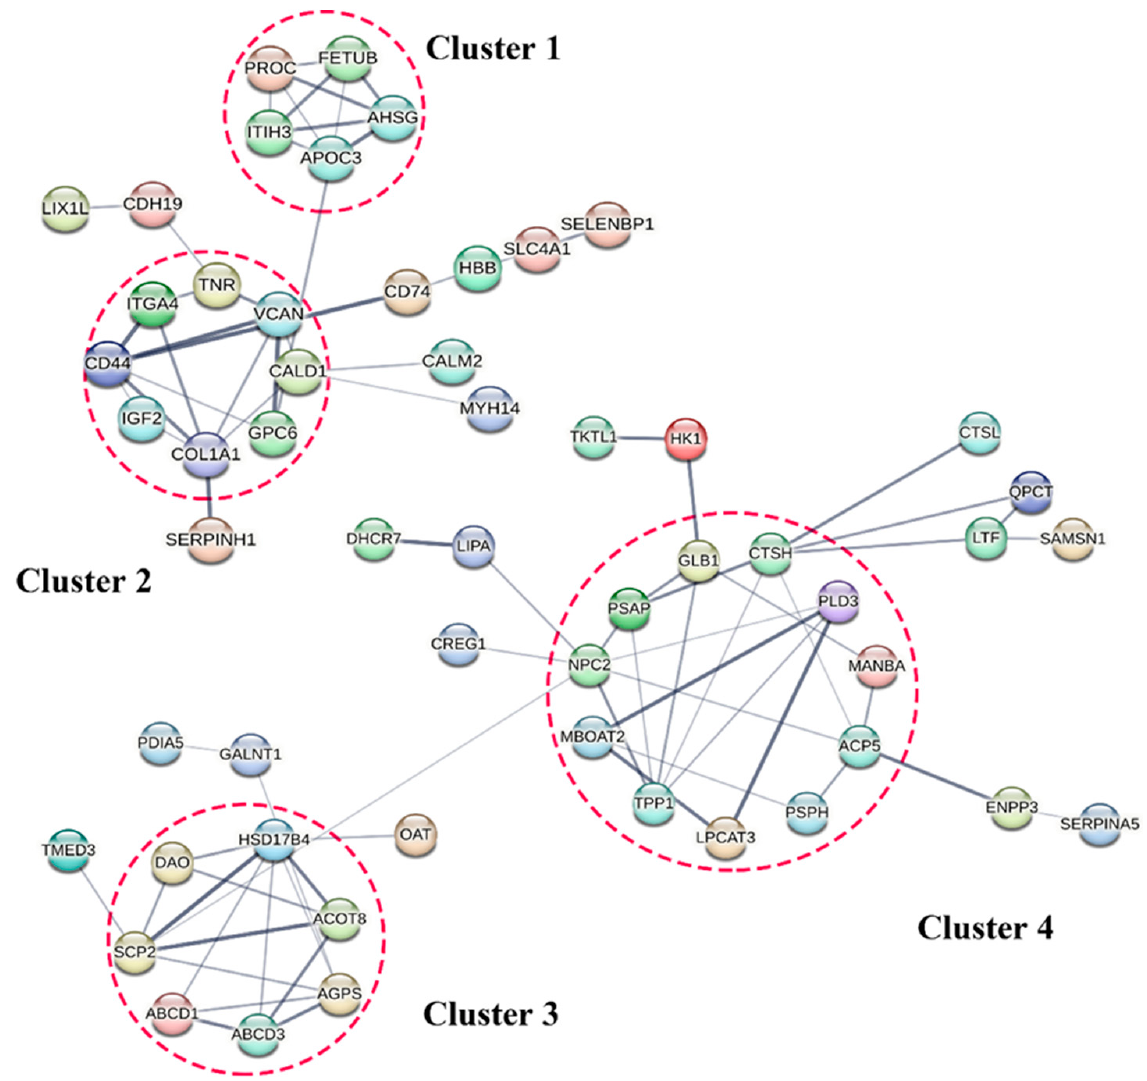
Figure 6. Network diagram of differential protein interaction in epididymal cauda. The protein– protein interaction network diagram was drawn using STRING. Cluster 1 and Cluster 2 represented upregulated DEP aggregation. Cluster 3 and Cluster 4 were formed when DEPs were downregu- lated.